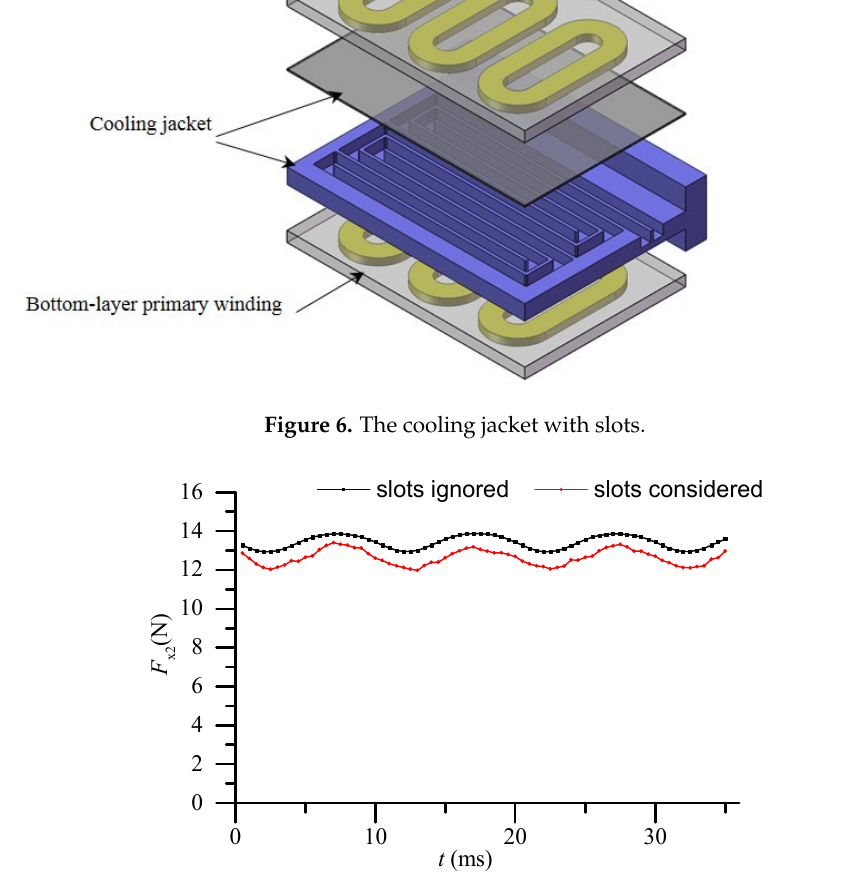
Figure 7. Comparison of eddy current braking force F x2 between slots ignored and slots considered.